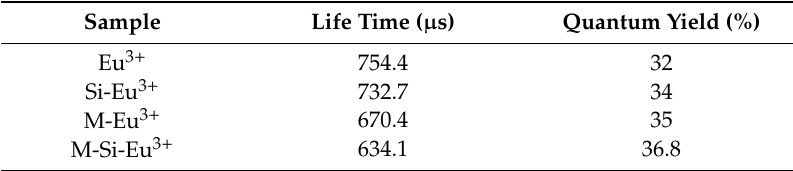
Table 2. Data on lifetime and quantum yield of Eu 3 + , Si-Eu 3 + , M-Eu 3 + , M-Si-Eu 3 + .